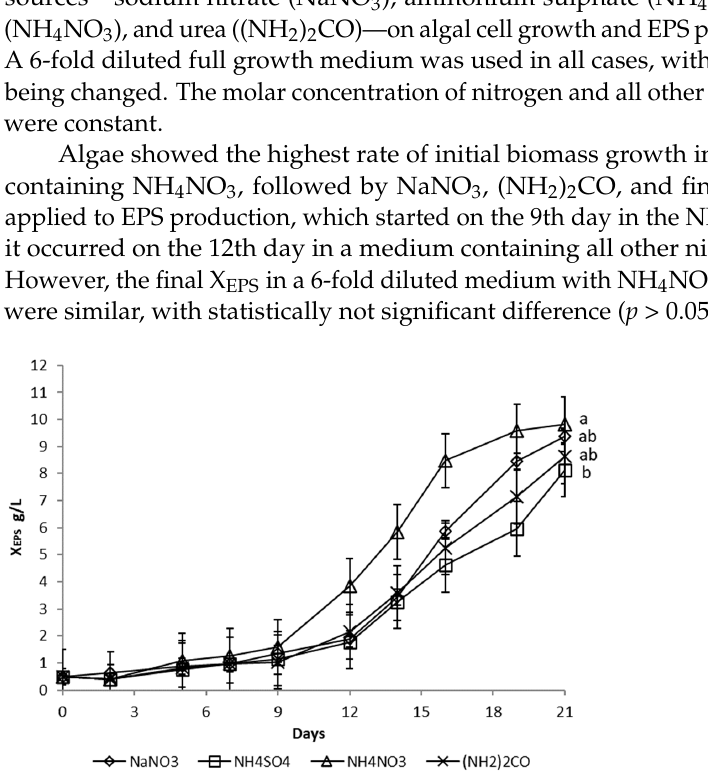
Figure 5. Influence of a nitrogen source on the production of extracellular polysaccharides (X EPS ) during cultivation of Dictyosphaerium chlorelloides in a 6-fold diluted full medium. Means with at least one letter the same are not significantly different ( p > 0.05). Comparison of statistical significance is presented for X EPS on the 21st day of cultivation. Error bars indicate the standard deviations. All experiments were carried out in three biological replicates.